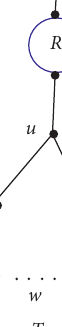
Figure 7: The tree T